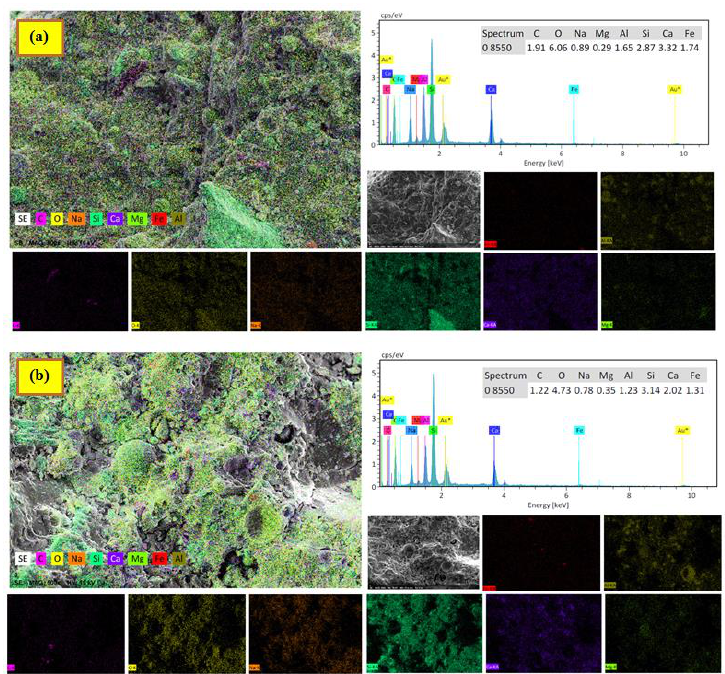
Figure 14. EDX spectra and maps of AAMs containing BGWNP at ( a ) 5% and ( b ) 15% .